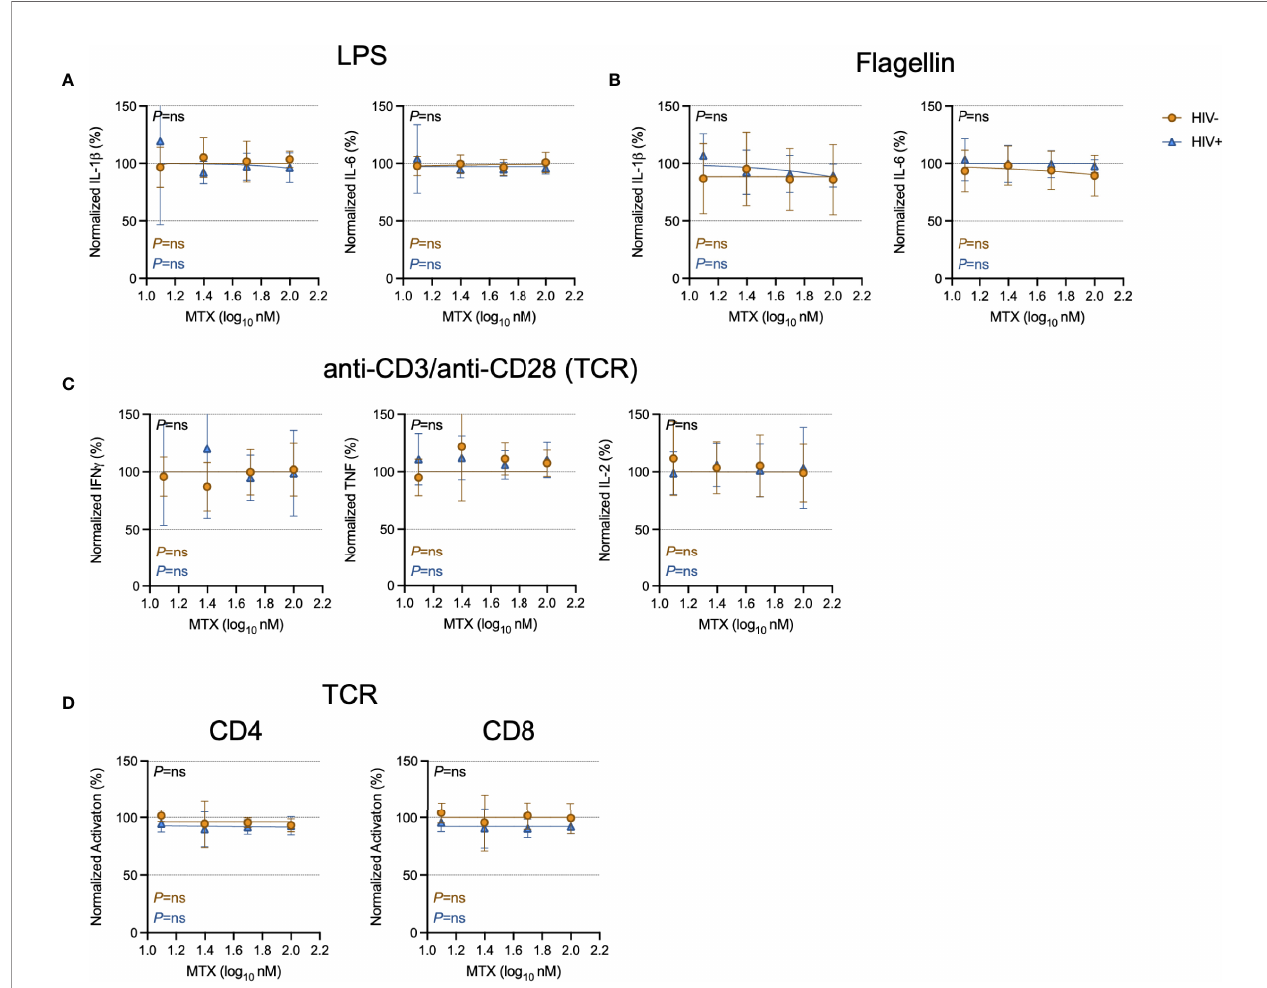
FIGURE 1 | Minimal effect of MTX on cytokine production and activation in vitro . Freshly isolated PBMCs from PWH (HIV+, blue triangles, n=6) or HIV-uninfected controls (HIV-, gold circles, n=6) were stimulated overnight with LPS (10ng ml -1 ) (A) , fl agellin (500ng ml -1 ) (B) , or anti-CD3 (10 m g ml -1 ) and anti-CD28 (5 m g ml -1 )(TCR) (C) in the presence or absence of MTX at indicated concentrations. At the end of the culture, supernatants were collected and analyzed by ELISA for indicated cytokines. (D) Cryopreserved PBMCs from PWH (blue triangles, n=6) or HIV-uninfected controls (gold circles, n=8-11) were stimulated for 4 days with anti-CD3 (10 m g ml -1 ) and anti-CD28 (5 m g ml -1 )(TCR) in the presence or absence of MTX at indicated concentrations. At the end of the culture, CD4 (left) and CD8 (right) T cells were analyzed by fl ow cytometry for expression of activation markers CD69 and CD25. Data were normalized to medium-only control values. P-values in black indicate whether one curve fi ts both HIV- and HIV+ donors; variable slope non-linear regression, log(inhibitor) vs. normalized response. P-values in color indicate whether the slope of each curve is signi fi cantly non-zero; simple linear regression. ns, not signi fi